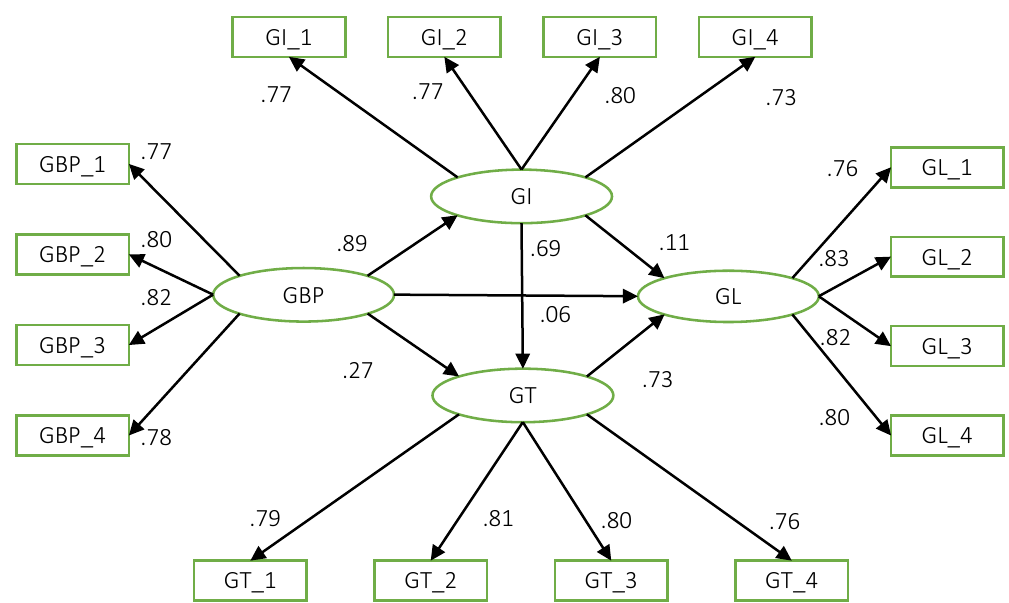
Figure 2. Results of Table 6 indicates the results of the mediation anal- ysis. The standardized regression weights of the path green banking practices to green loyalty de- creased to 0.817 (p = 0.001) and the path coeffi- cients of green banking practices to green image to green loyalty is 0.547 (p = 0.001). This supports hypothesis seven ( H7 ), and it can be asserted that green image mediates the relationship between green banking practices and green loyalty, which is in line with previous findings (Ibe-enwo et al., 2019). Further, in the test of mediating effect of green trust between green banking practices and green loyalty, the p-value of the path green bank- ing practices to green loyalty is not statistically significant (p = 0.416), implying that green trust does not significantly mediate the relationship be- tween green banking practices and green loyalty. Thus, hypothesis eight ( H8 ) is rejected.